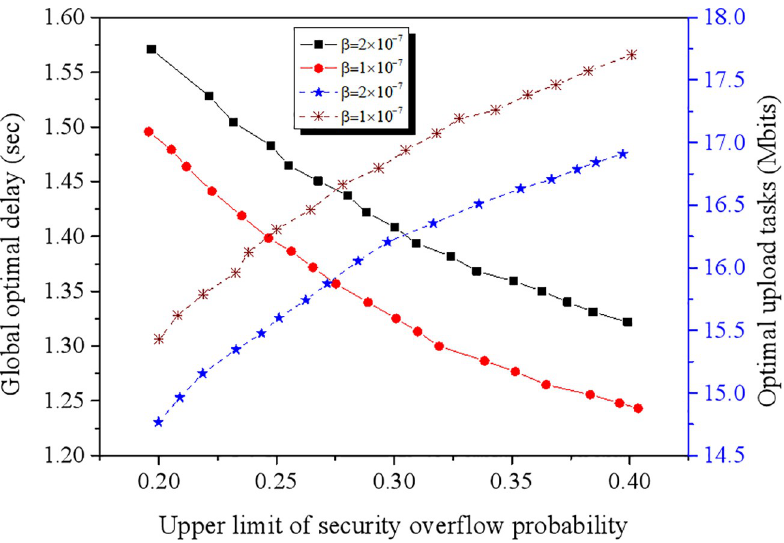
Fig 9. The impact of different eavesdropping channel strengths on the optimal distribution scheme. β , the eavesdropping channel strength.